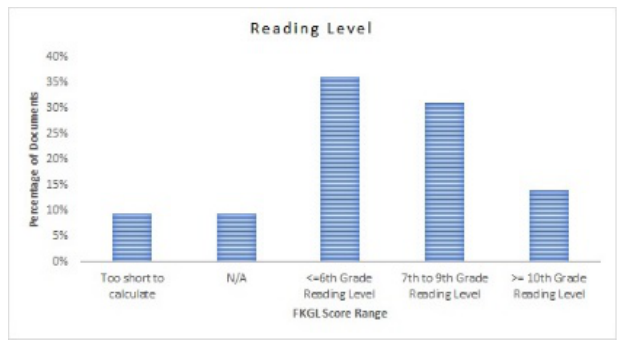
Figure 4 Distribution of materials by readability assessment using FKGL. Materials with a FKGL at or below the sixth-grade level are easy to read, seventh- to ninth-grade level are of average difficulty, and tenth-grade or higher are difficult to